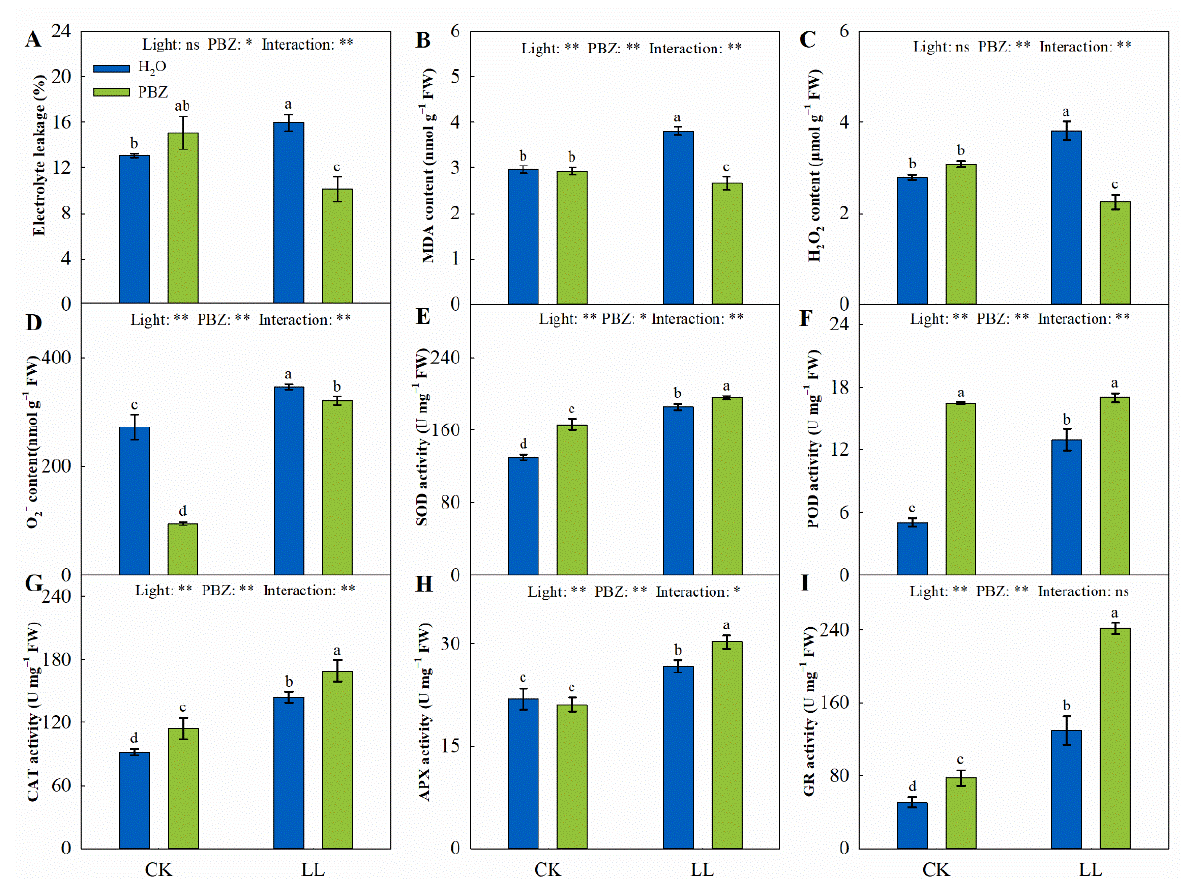
Figure 4. Changes in electrolyte leakage (EL, ( A )), MDA content ( B ), H 2 O 2 content ( C ), superoxide radical content (O 2 · − , ( D )), superoxide dismutase (SOD) activity ( E ), peroxidase (POD) activity ( F ), catalase (CAT) activity ( G ), ascorbate peroxidase (APX) activity ( H ), and glutathione reductase (GR) activity ( I ) of tall fescue leaves induced by paclobutrazol under control (CK) and LL stress. * and ** indicate significant differences at p < 0.05 and p < 0.01, respectively. ns indicates not significant. Different letters above the vertical bars indicate significant differences at p < 0.05 according to Duncan’s multiple range test.